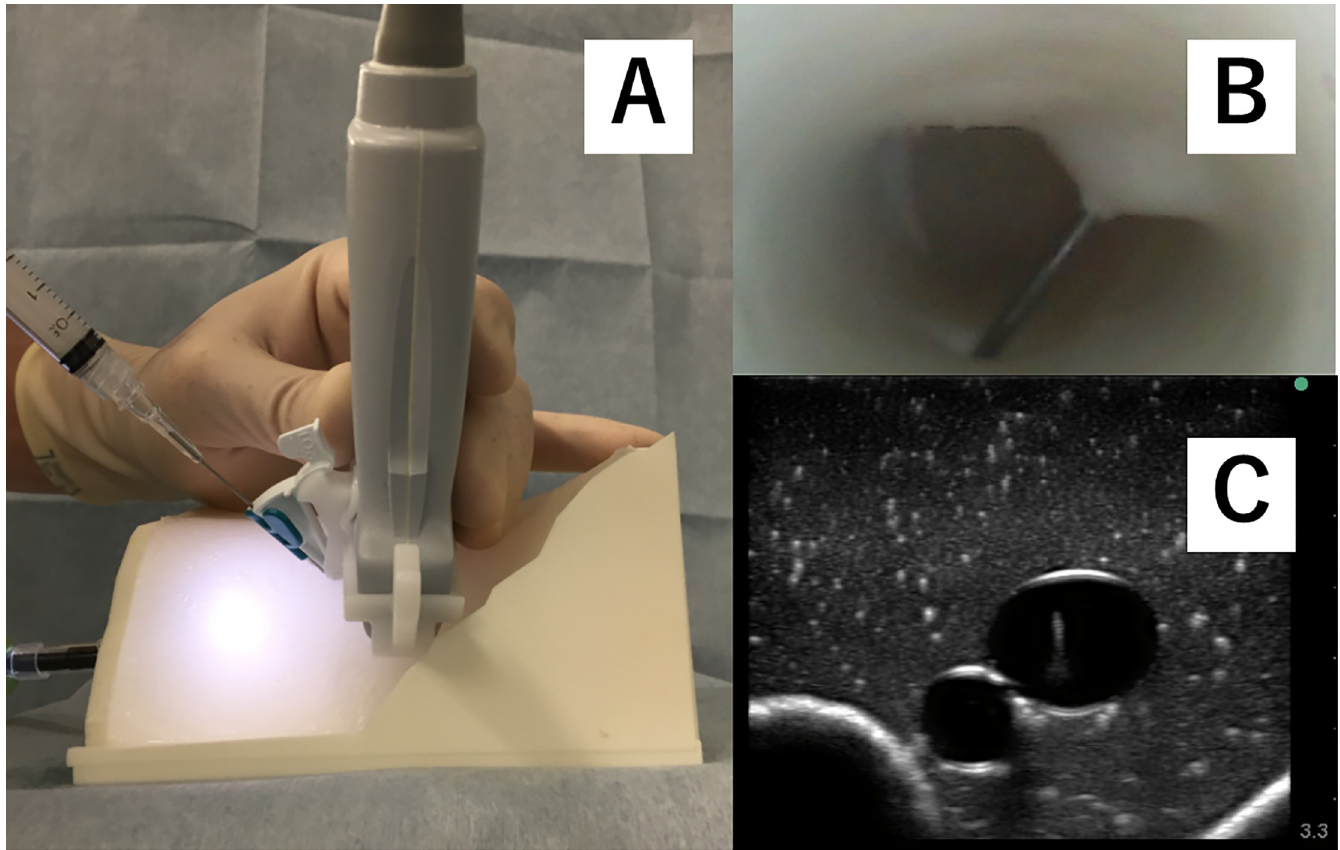
Fig 4. A commercial needle guide for out-of-plane approach. Panel A: The needle is inclined at 60 degrees to the target vein. Panel B: Internal view of the simulated vein. Panel C: The needle tip appears in the ultrasound image at a depth of 1.5 cm.